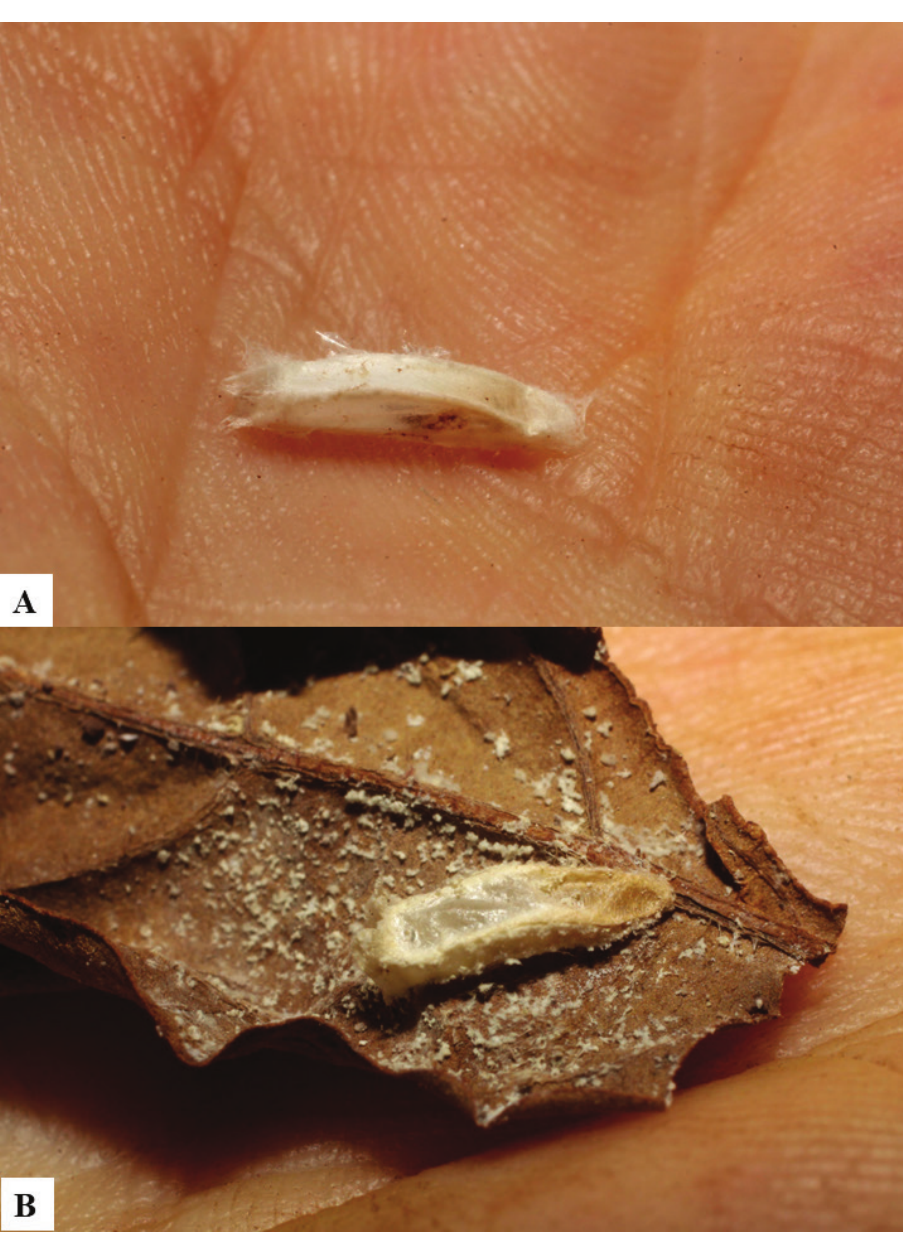
Figure 14. A, B Cocoons of Dolichogenidea josealfredohernandezi sp.